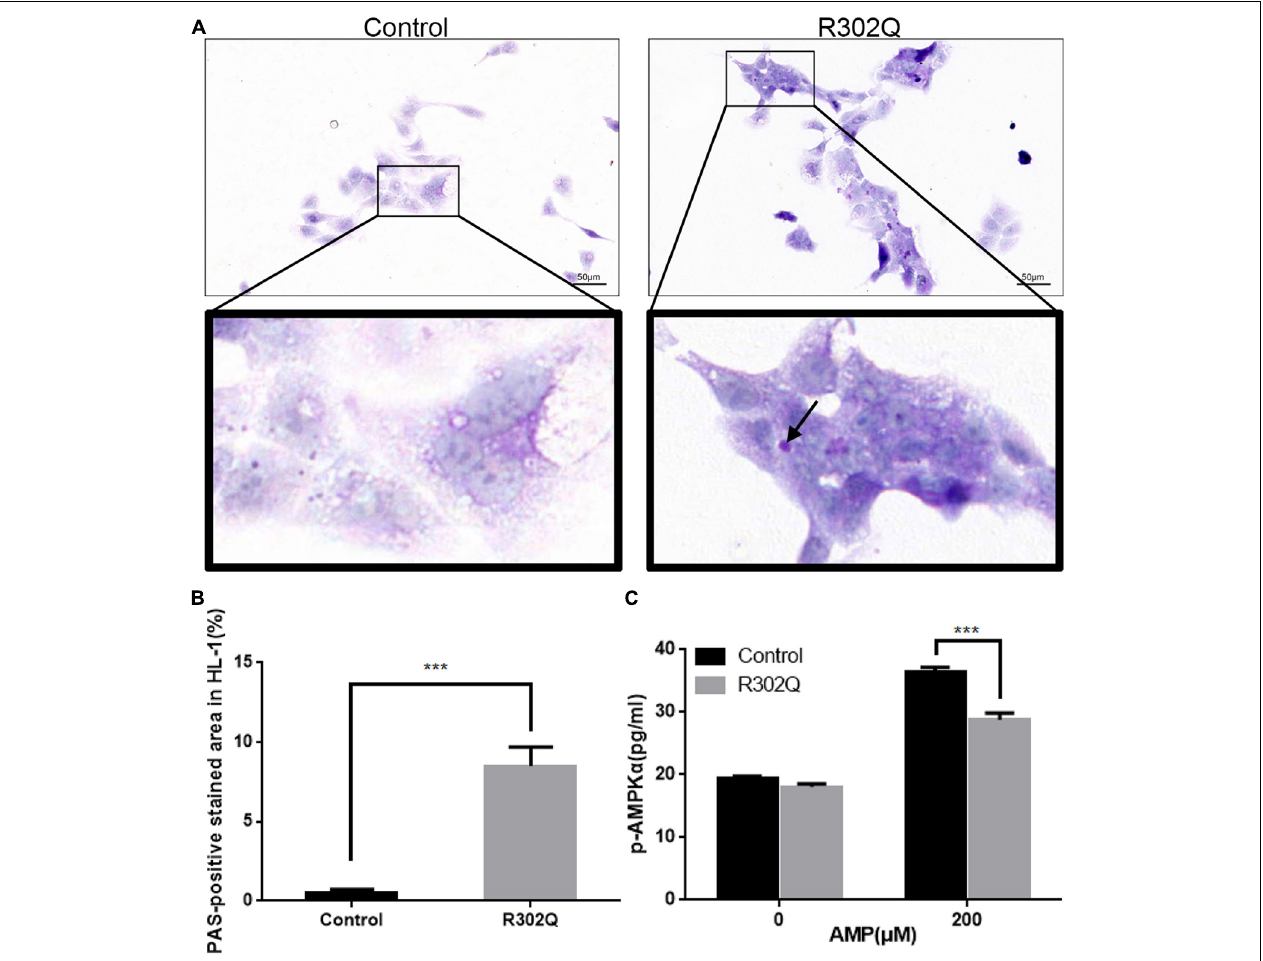
FIGURE 4 | Molecular changes in HL-1 cells overexpressing PRKAG2 -R302Q. (A) The glycogen content in HL-1 cells was analyzed by PAS staining (scale bar = 50 µ m). (B) Quantitative analysis of the PAS-positive stained area in HL-1 cells. (C) The level of p-AMPK α expression was determined by ELISA ( n = 3). All data were analyzed by the Student’s t –test ( n = 3, *** p <